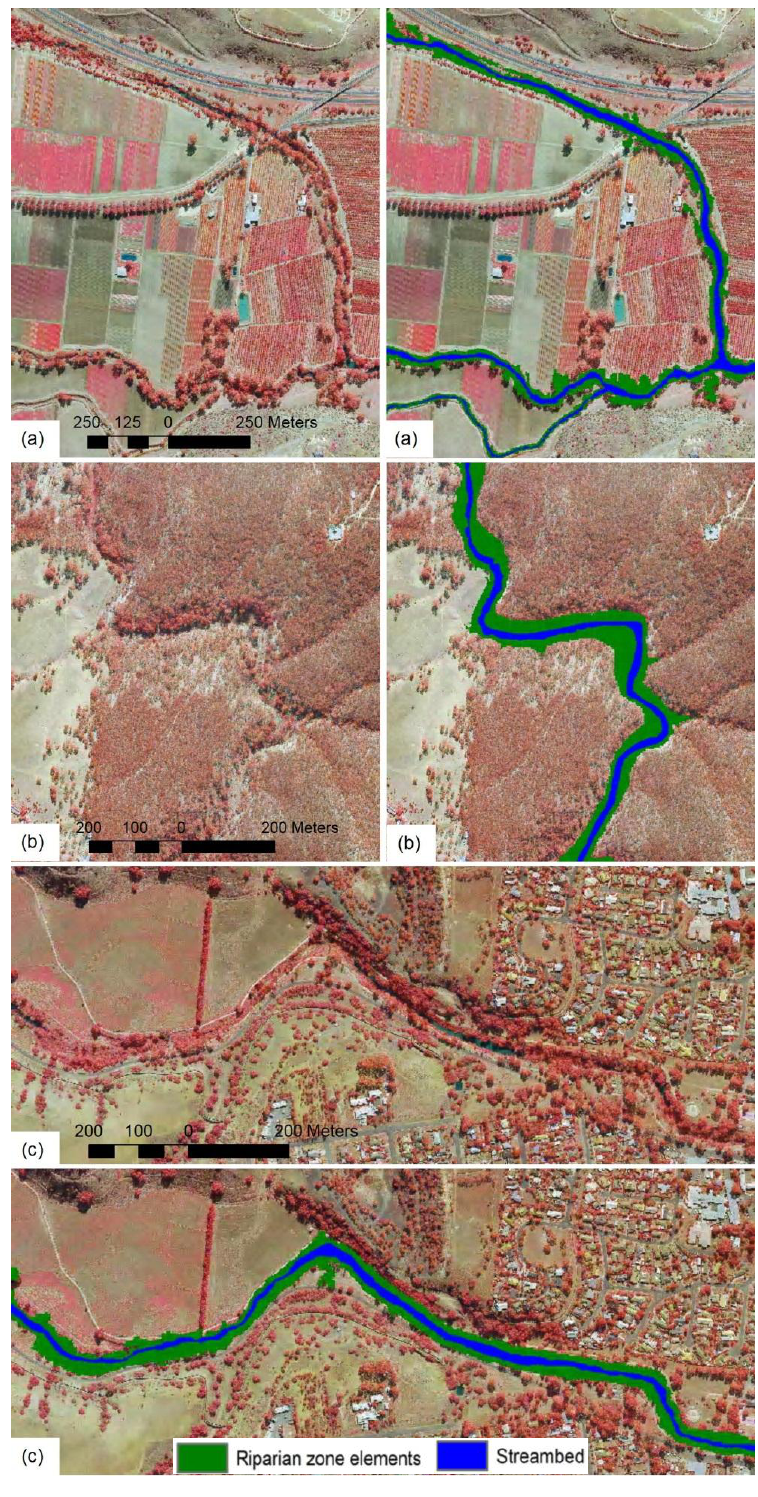
Figure 7. Mapping results showing streambed and riparian zone extent with UltracamD image data used as a backdrop for an (a) agricultural; (b) forested; and (c) urbanized area depicted both without and with the classification